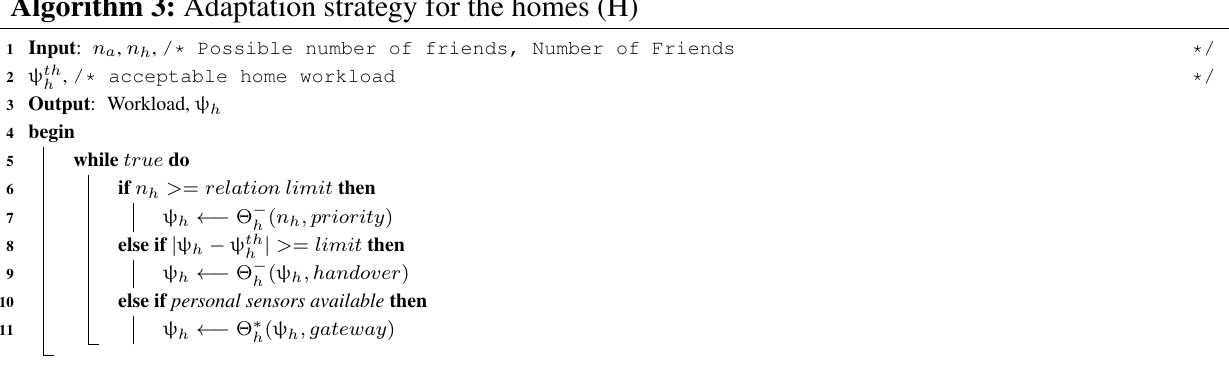
Algorithm 3: Adaptation strategy for the homes